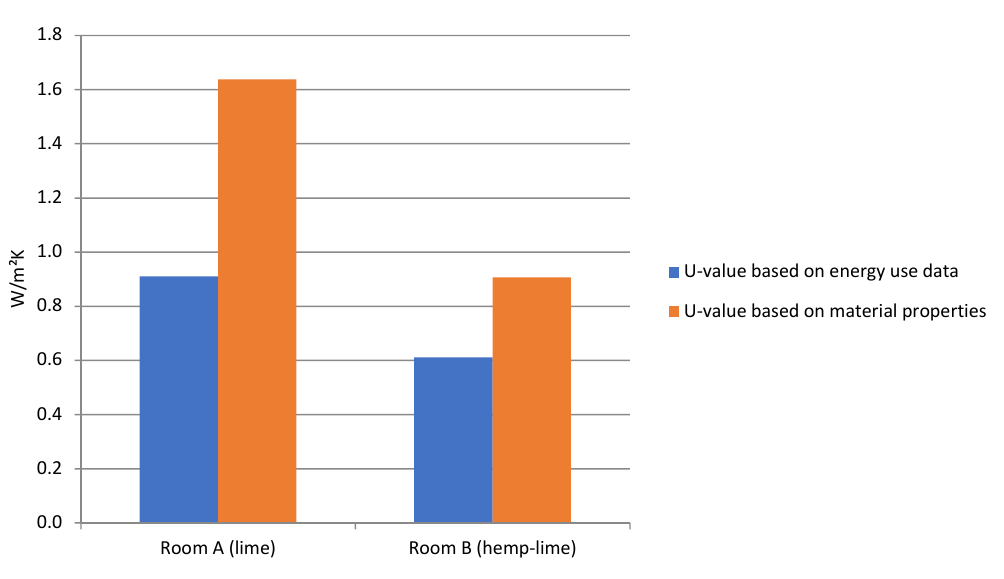
Figure 14. Thermal transmittance through the test walls based on energy use data and U-value based on material properties. Table 5. Thermal transmittance through the test walls, based on material properties and based on energy use